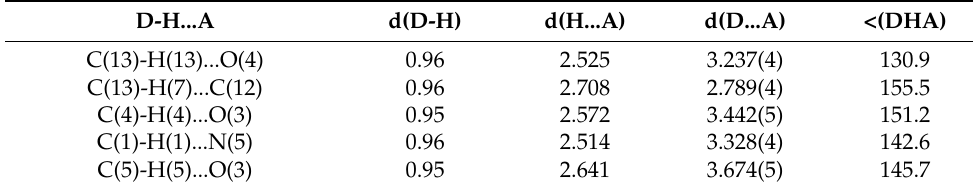
Table 3. Selected non-covalent contacts in the crystal structure of 1 [Å and ◦ ].